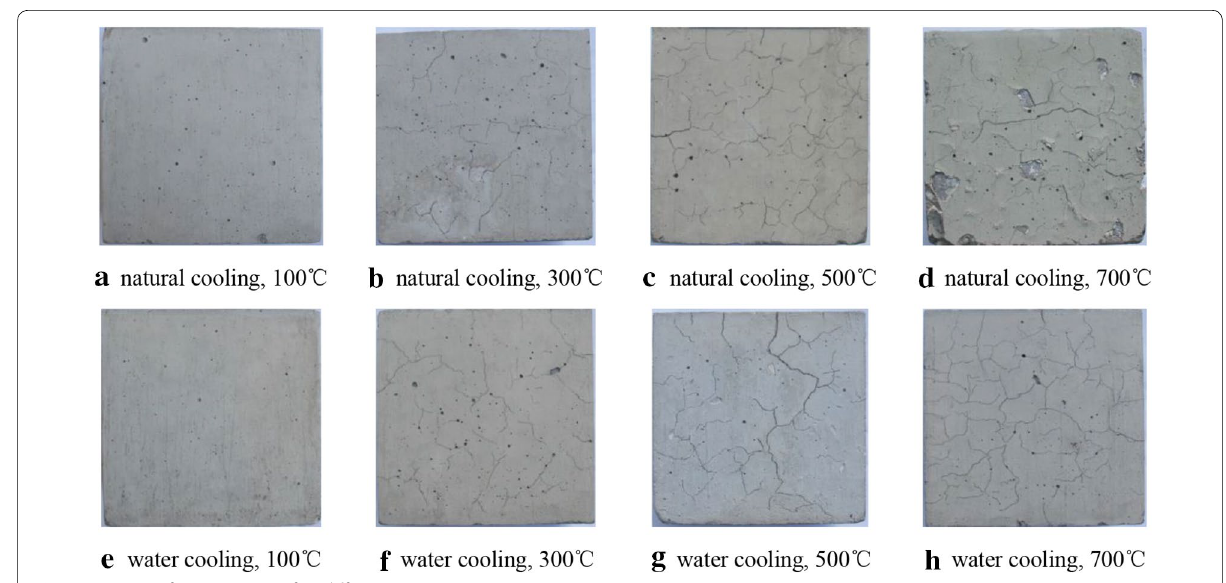
Fig. 3 Pictures of specimen T5 after different temperatures.